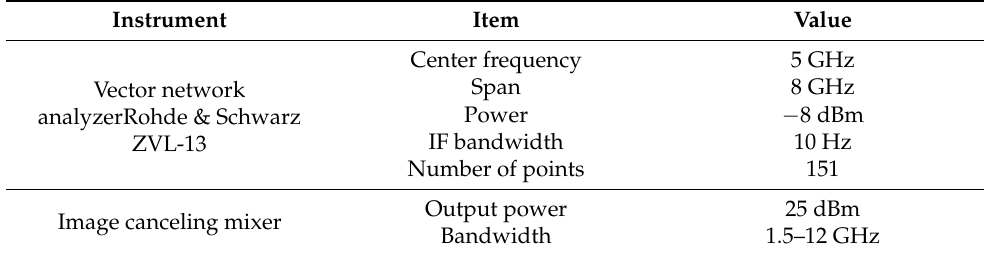
Table 2. Measurement setting of network analyzer and characteristics of image canceling mixer.